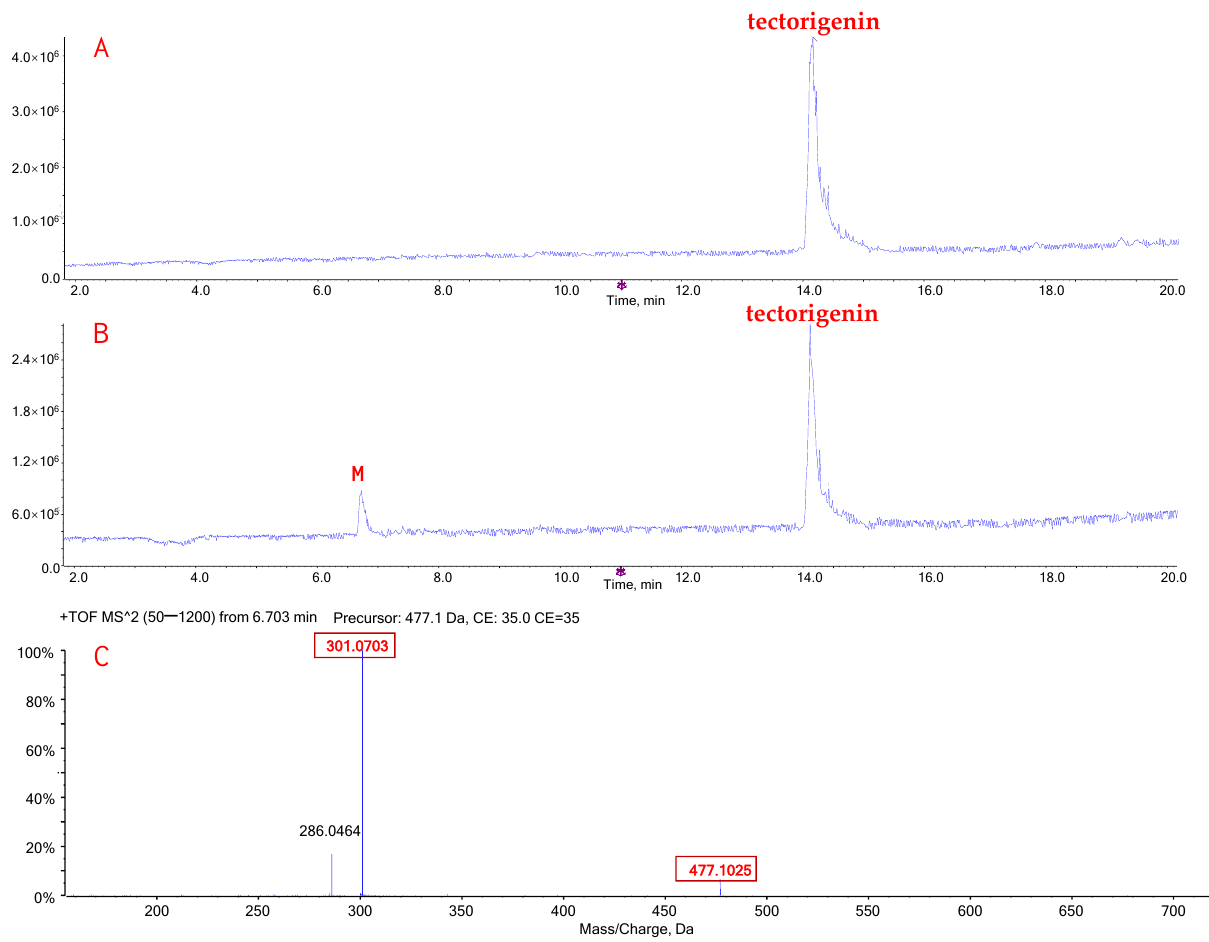
Figure 2. Representative chromatograms of tectorigenin and its glucuronide metabolites (M). Total ion chromatogram (TIC) after incubation of tectorigenin for 0 h ( A ) and 0.5 h ( B ) at 37 °C; mass spectrometric fragmentation characteristics of glucuronide metabolite of tectorigenin ( C ). When irigenin was incubated with HLMs and UDPGA, two metabolites (M1 and M2) were detected (Figure 3A,B). M1 (retention time: 7.7 min) and M2 (retention time: 9.1 min) had the same exact molecular weight, 537.12 Da ([M + H] + ), which was 176.03 Da higher than that of irigenin. The most abundant product ions of M1 and M2 were both 361.09 Da and were generated by a neutral loss of 176 Da (Figure 3C,D), indicating that the two metabolites were formed by glucuronidation of irigenin.